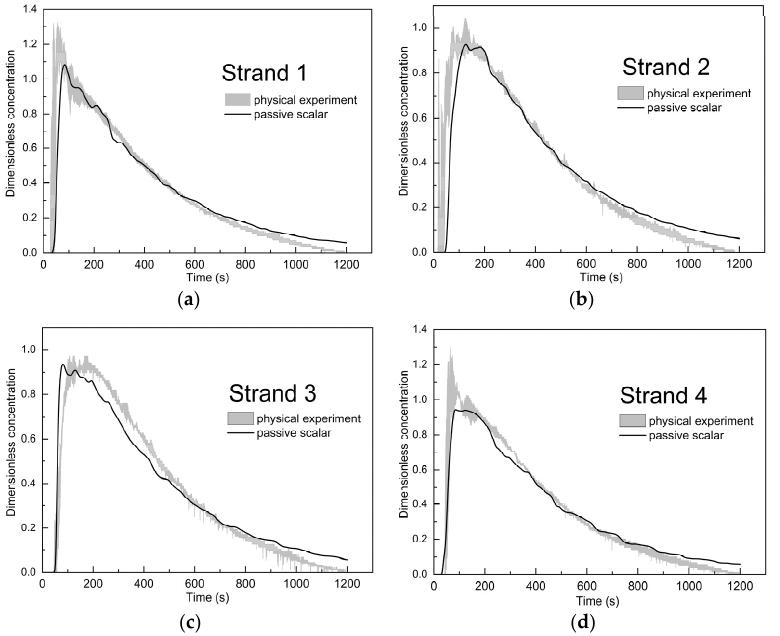
Figure 7. The comparison of RTD curves of physical model and numerical simulation of double-weir tundish: ( a ) strand 1, ( b ) strand 2, ( c ) strand 3, ( d ) strand 4.